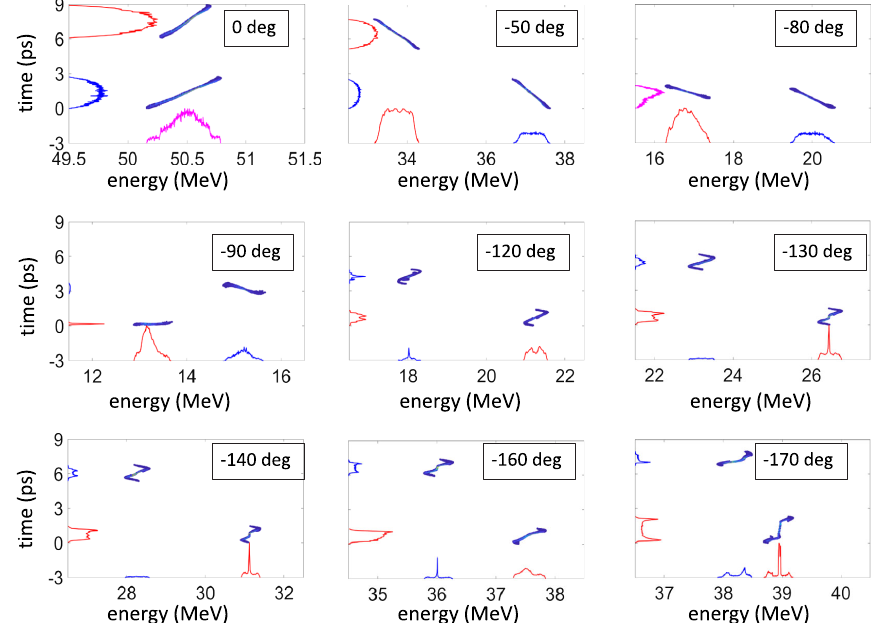
FIG. 5. Simulated phase space distributions of twin bunches (blue: bunch 1, red: bunch 2) under different TWA phases; the projection onto the x-axis is the beam energy, and the projection onto the y-axis is the time